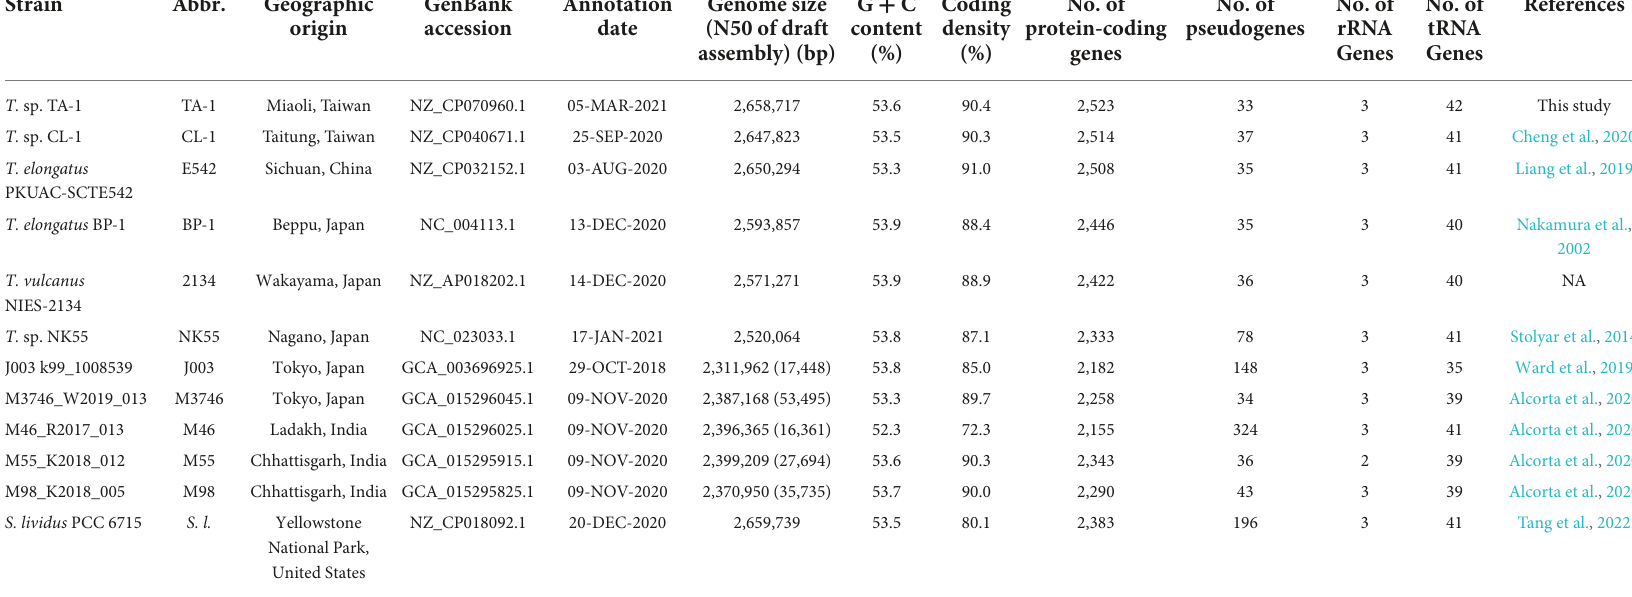
TABLE 1 List of genome sequences included in the comparative